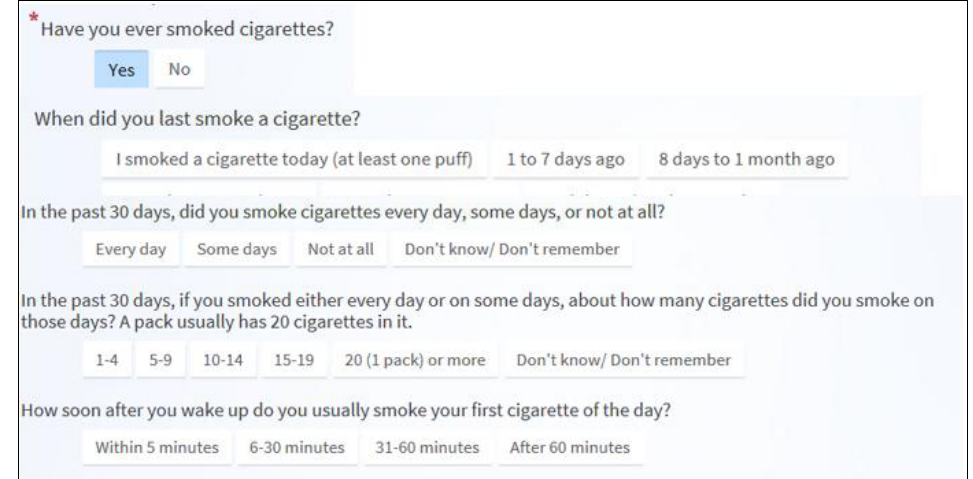
Figure 1. Patient view of tobacco screener items. (Nelson, 2020). © 2020 Epic Systems Corporation. Used with permission.